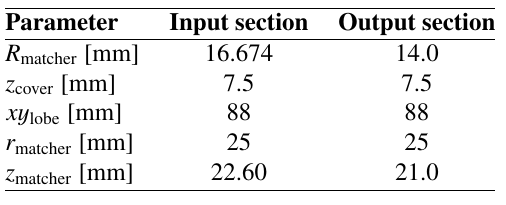
Table 3. Parameters for input and output sections of the RFQ. Refer to Fig. 12 for description of parameters.